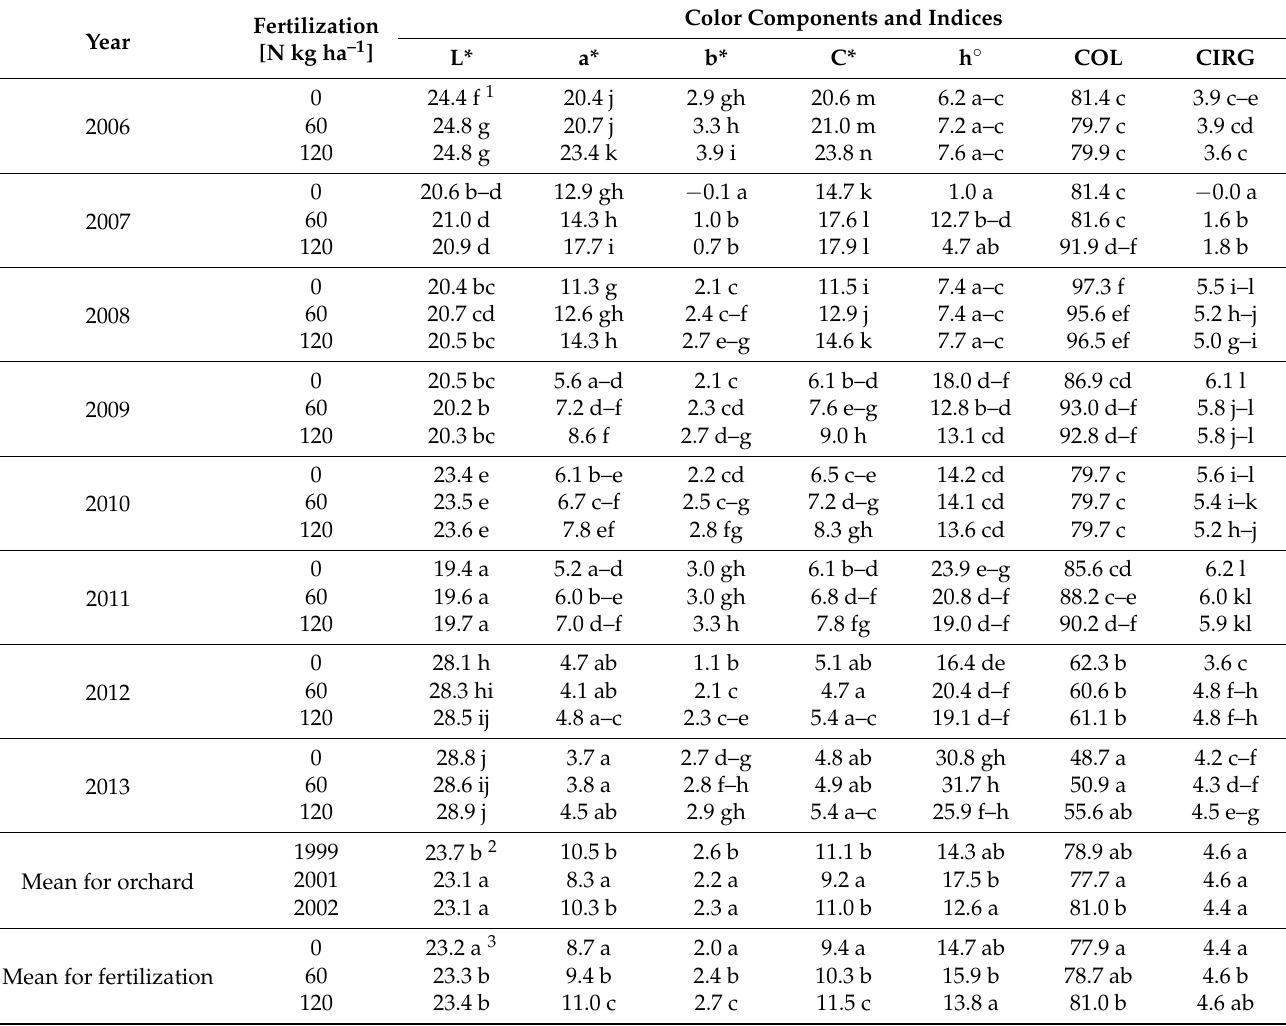
Table 10. Color space of skin of sour cherry cv. ‘Łut ó